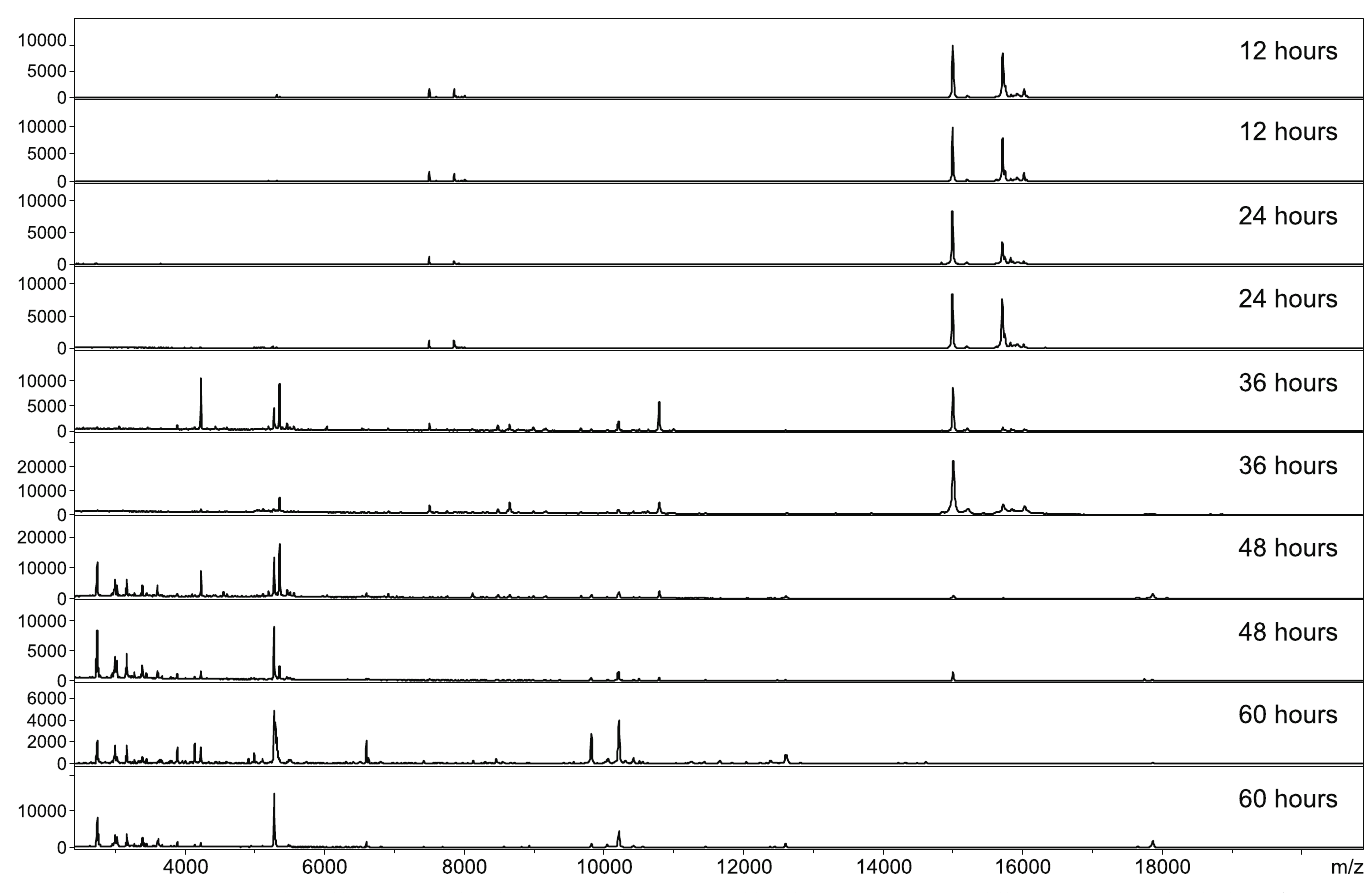
Fig 2. MALDI-TOF protein profiles of homogenized female abdomens of P . perniciosus bloodfed on SKH1 mouse at different time points after feeding. The fragments of hemoglobin were produced by blood digestion in the 24-36h PBM time interval. For each time point the spectra of two females are